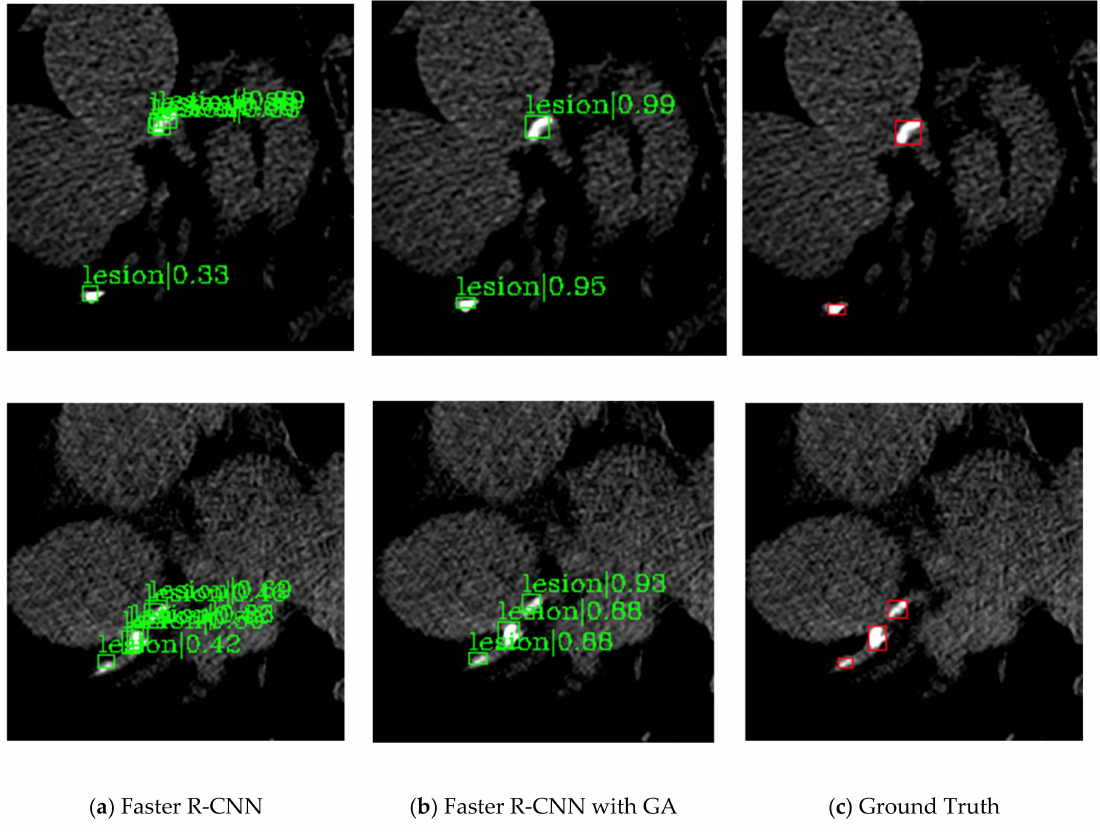
Figure 4. Two examples of the redundant detection of Faster R-CNN. ( a ) The detection results of Faster R-CNN. ( b ) The detection results of faster R-CNN with guided anchoring. ( c ) The ground truths of the